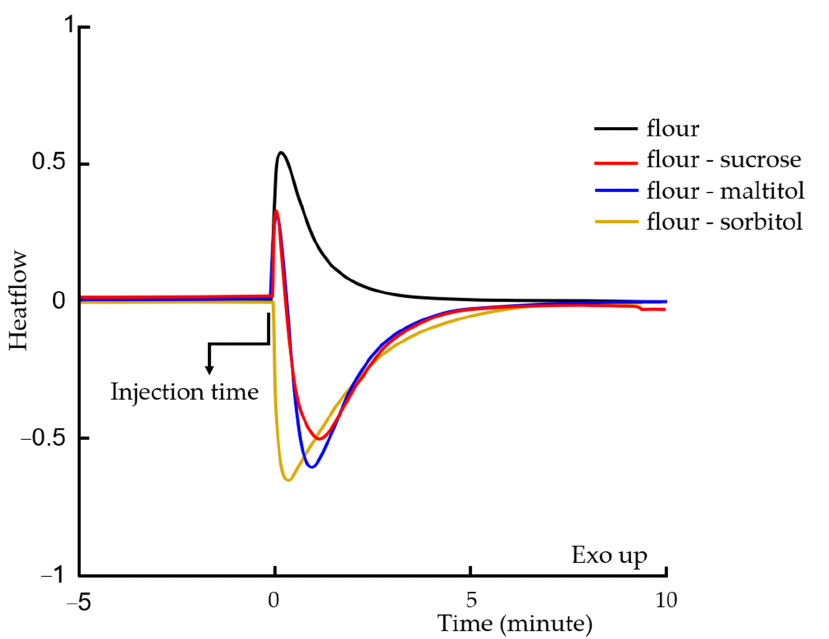
Figure 10. Representative thermograms of flour-water, flour-sucrose–water, flour-maltitol–water and flour-sorbitol–water mixtures at 20 ◦ C (exotherm